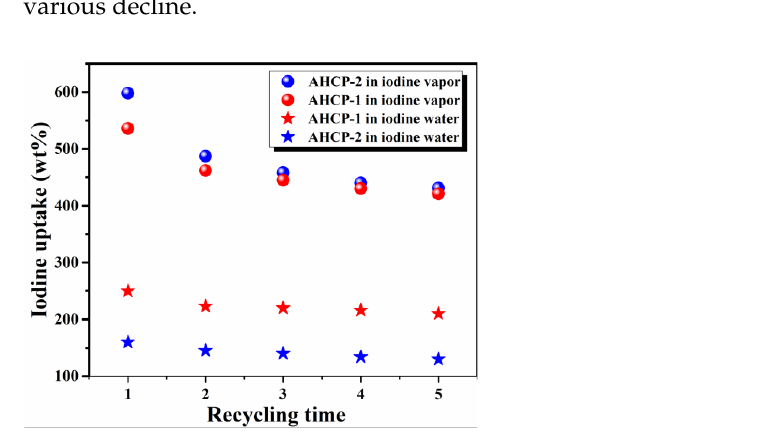
Figure 4. Recycling experiment of AHCPs for iodine capture in iodine aqueous solution at room temperature and in iodine vapor at 75 °C.